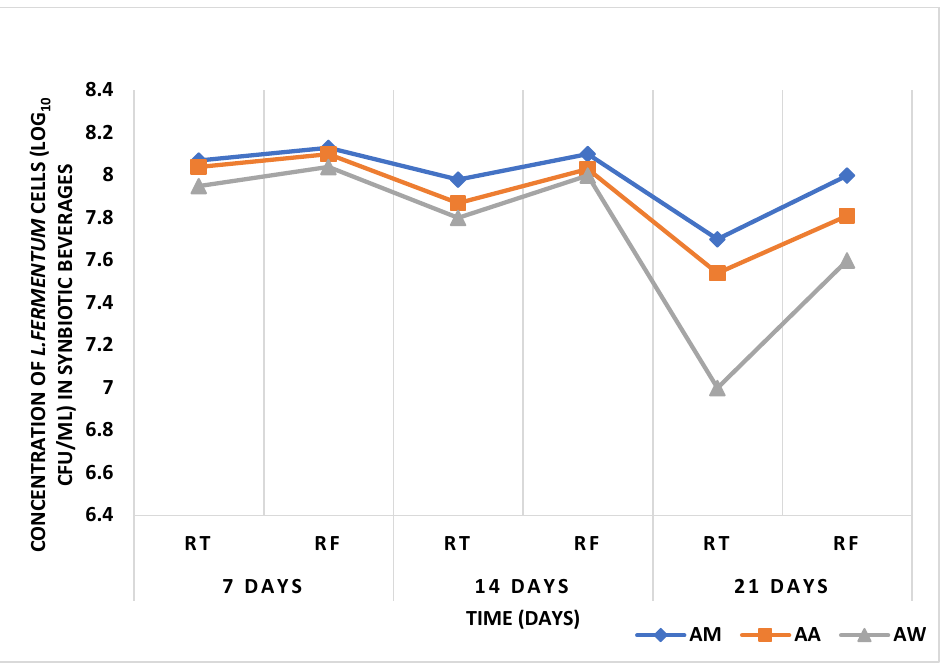
Figure 11. The survival of L. fermentum in the synbiotic fruit beverages after 7, 14, and 21 days at room temperature (RT) and refrigeration temperature (RF). Within 7 days of storage at room and refrigeration temperatures, all LAB isolates survived, with the number of L. fermentum cells in the synbiotic beverages being the highest. However, the survival of L. fermentum in the refrigerated synbiotic beverages was the highest. Key: AM — baobab fruit pulp and milk beverage; AA — baobab fruit pulp and apple juice beverage; AW — baobab fruit pulp and apple juice beverage